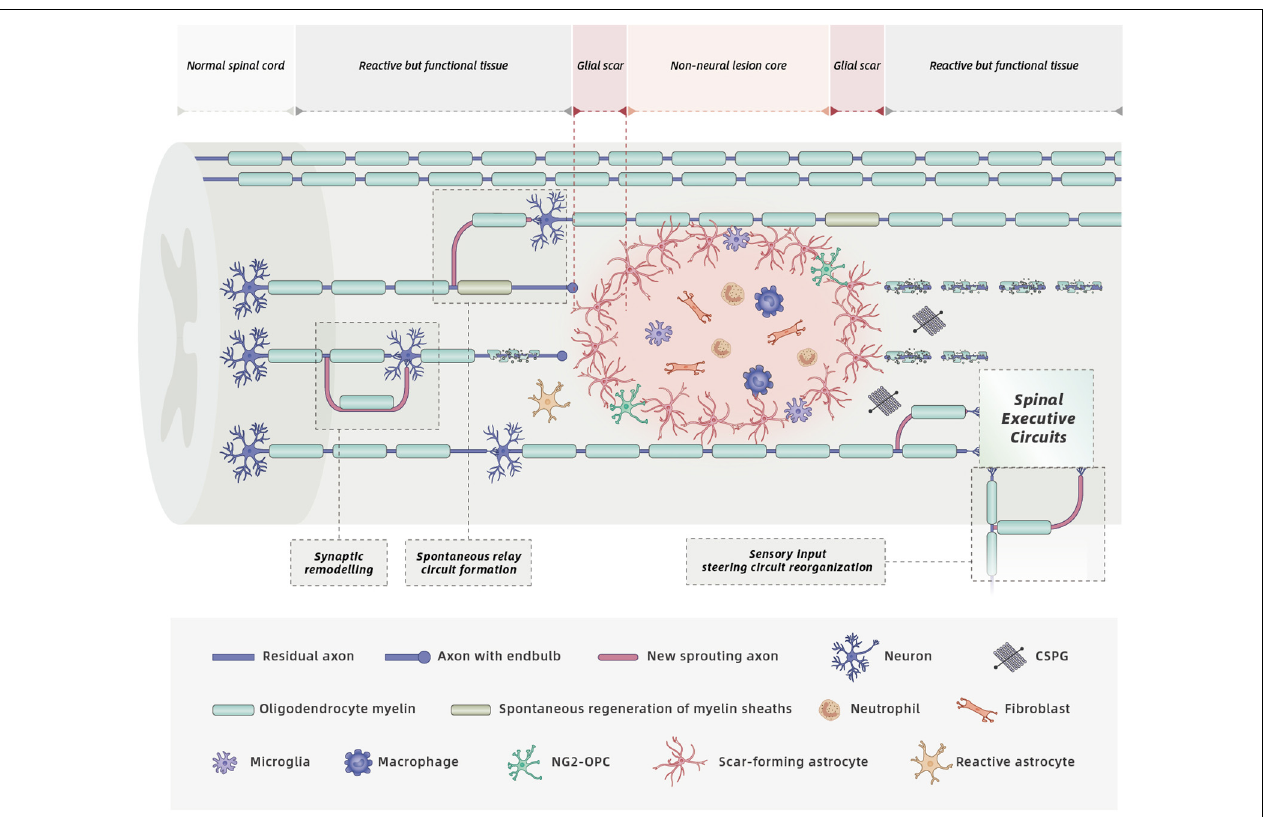
FIGURE 2 | Cell biology and spontaneous recovery after SCI. Mature SCI lesions have three different compartments: (1) a central non-neural lesion core, consisting of stromal cells, meningeal fibroblasts, and pericytes. (2) a narrow glial scar, consisting of reactive astrocyte and microglia, that intimately surround the lesion core, and (3) a large surrounding zone of functional neural tissue (O’Shea et al., 2017; Courtine and Sofroniew, 2019). SCI triggers complex pathological events including considerable loss of axons, neurons, and oligodendrocytes, infiltration of circulating immune cells, release of detrimental molecules by multiple cells, and glial scar formation. These processes within distinct SCI lesion compartments contribute to functional impairments. Spontaneous recovery can occur due to spontaneous circuit reorganization, spontaneous regeneration of myelin sheaths (produced by both oligodendrocytes and endogenous SCs) and spinal cord automaticity. However, spontaneous axonal regeneration is hampered by the increased deposition of CSPGs secreted by activated cells, and increased production of myelin-associated inhibitory molecules by the gradual degradation of injured oligodendrocyte myelin.